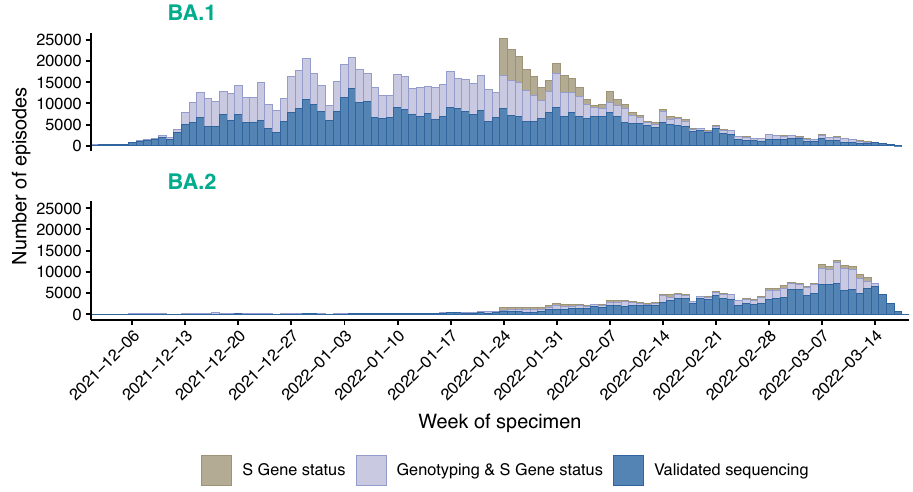
Fig. 1 | Time series of BA.1 and BA.2 cases in England, 01 December 2021 to 25 March 2022. Descriptive frequencies of the earliest specimen date of COVID-19 cases with Omicron lineages BA.1 (top panel) and BA.2 (bottom panel), in England between 01 December 2021 and 25 March 2022 ( n =1,243,212). COVID-19: